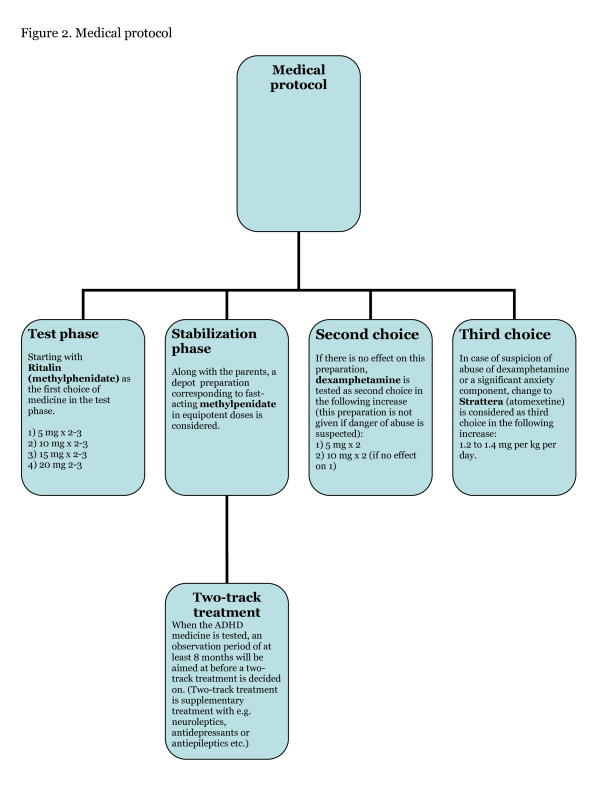
Medical protocol.